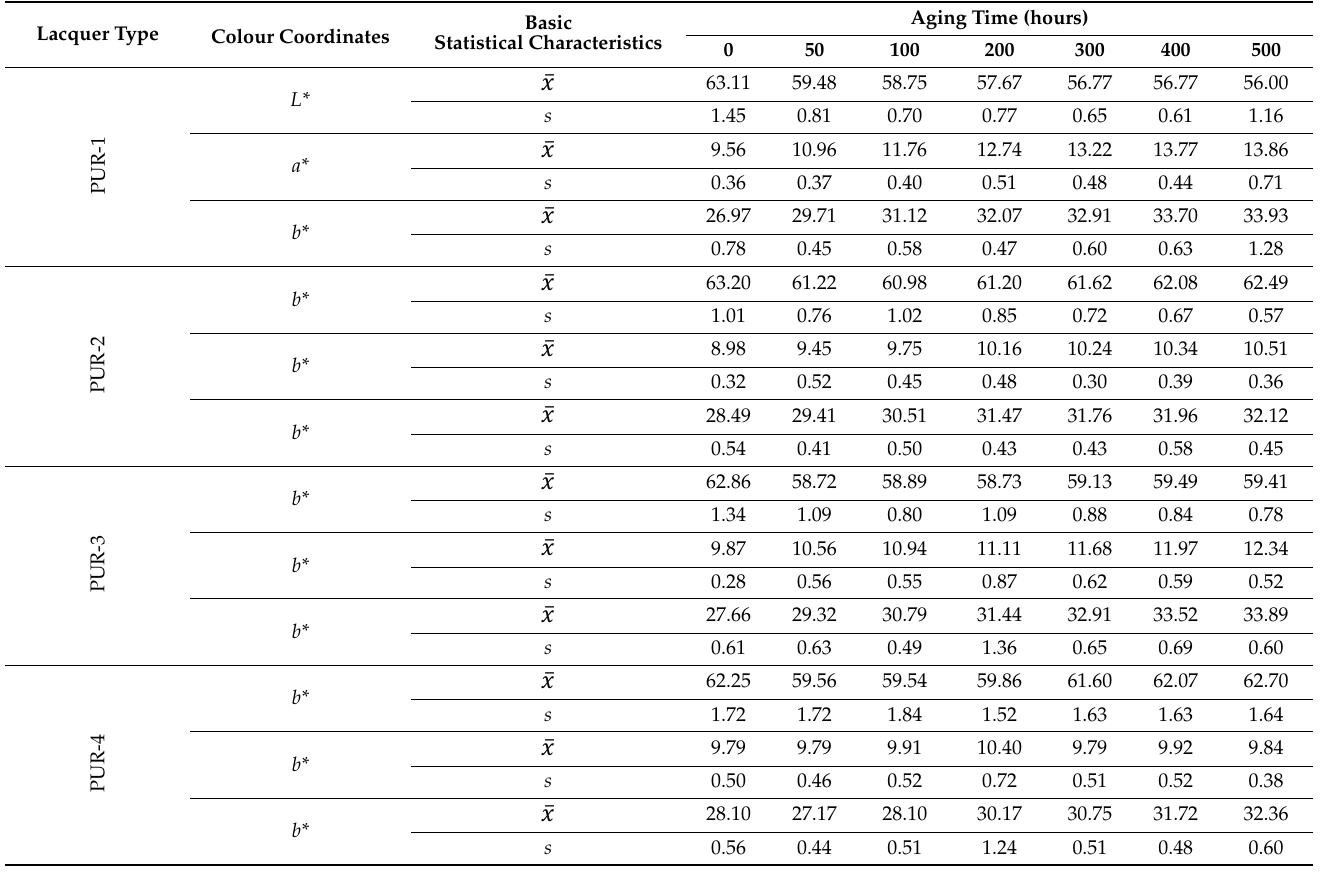
Table 3. Basic statistical characteristics of colour coordinates L * , a * , and b * corresponding to different phases of the accelerated aging process of spruce wood surface-treated with polyurethane lacquers. (The number of measurements for each set n = 50.)